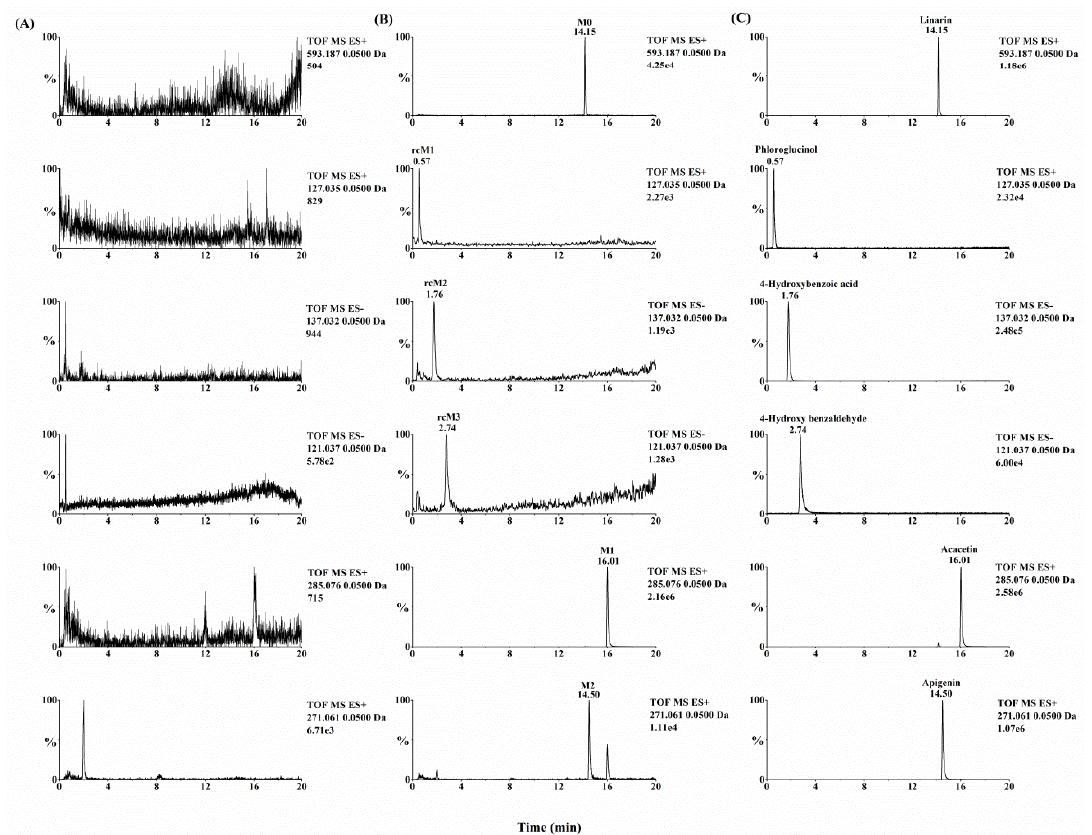
Figure 1. Extracted ion chromatograms of ( A ) linarin metabolites in rat intestinal flora incubated without linarin, ( B ) linarin metabolites in rat intestinal flora incubated with linarin and ( C ) reference standards. Compound abbreviations: M0, linarin; M1, acacetin; M2, apigenin; rcM1, phloroglucinol; rcM2, 4-hydroxybenzoic acid; rcM3, 4-hydroxy